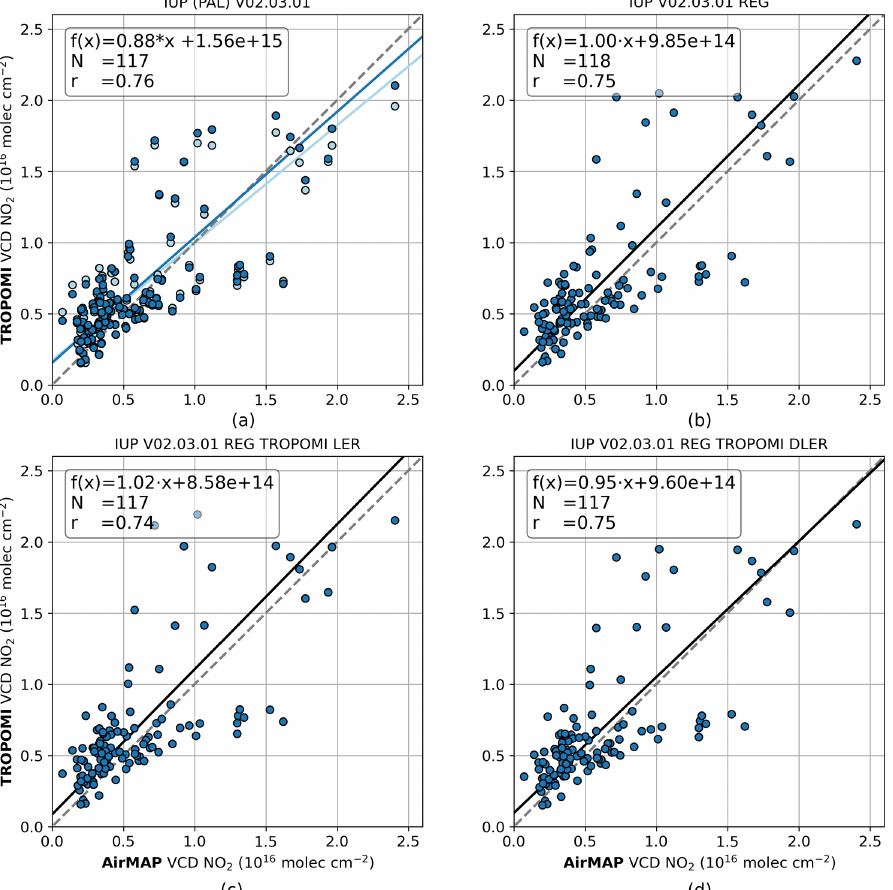
Figure 11. Scatter plots of TROPOMI NO 2 VCDs vs. co-located AirMAP NO 2 VCDs for different versions of TROPOMI data: (a) the IUP V02.03.01 in dark blue and the PAL V02.03.01 in light blue, with regression information given for IUP V02.03.01, (b) the IUP V02.03.01 with regional CAMS profiles replacing the TM5 profile information, (c) the IUP V02.03.01 with regional CAMS profiles and TROPOMI LER replacing the OMI LER, and (d) the IUP V02.03.01 with regional CAMS profiles and TROPOMI